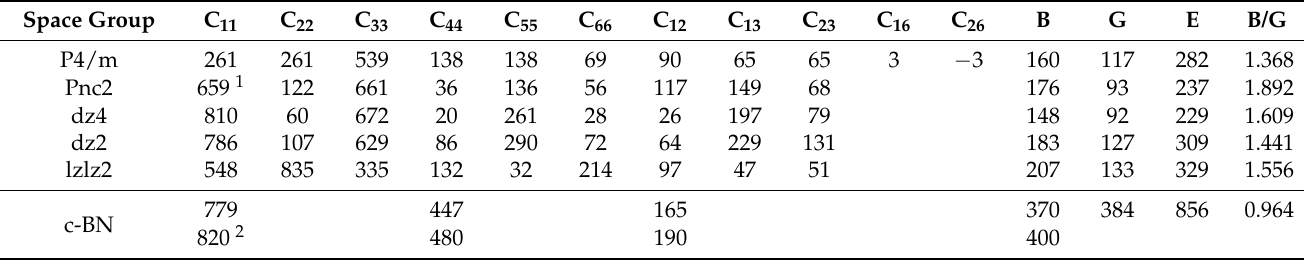
Table 2. The elastic parameters (GPa) and E (Young’s modulus), B (bulk modulus) and G (shear modulus) (GPa) of BN polymorphs with the GGA